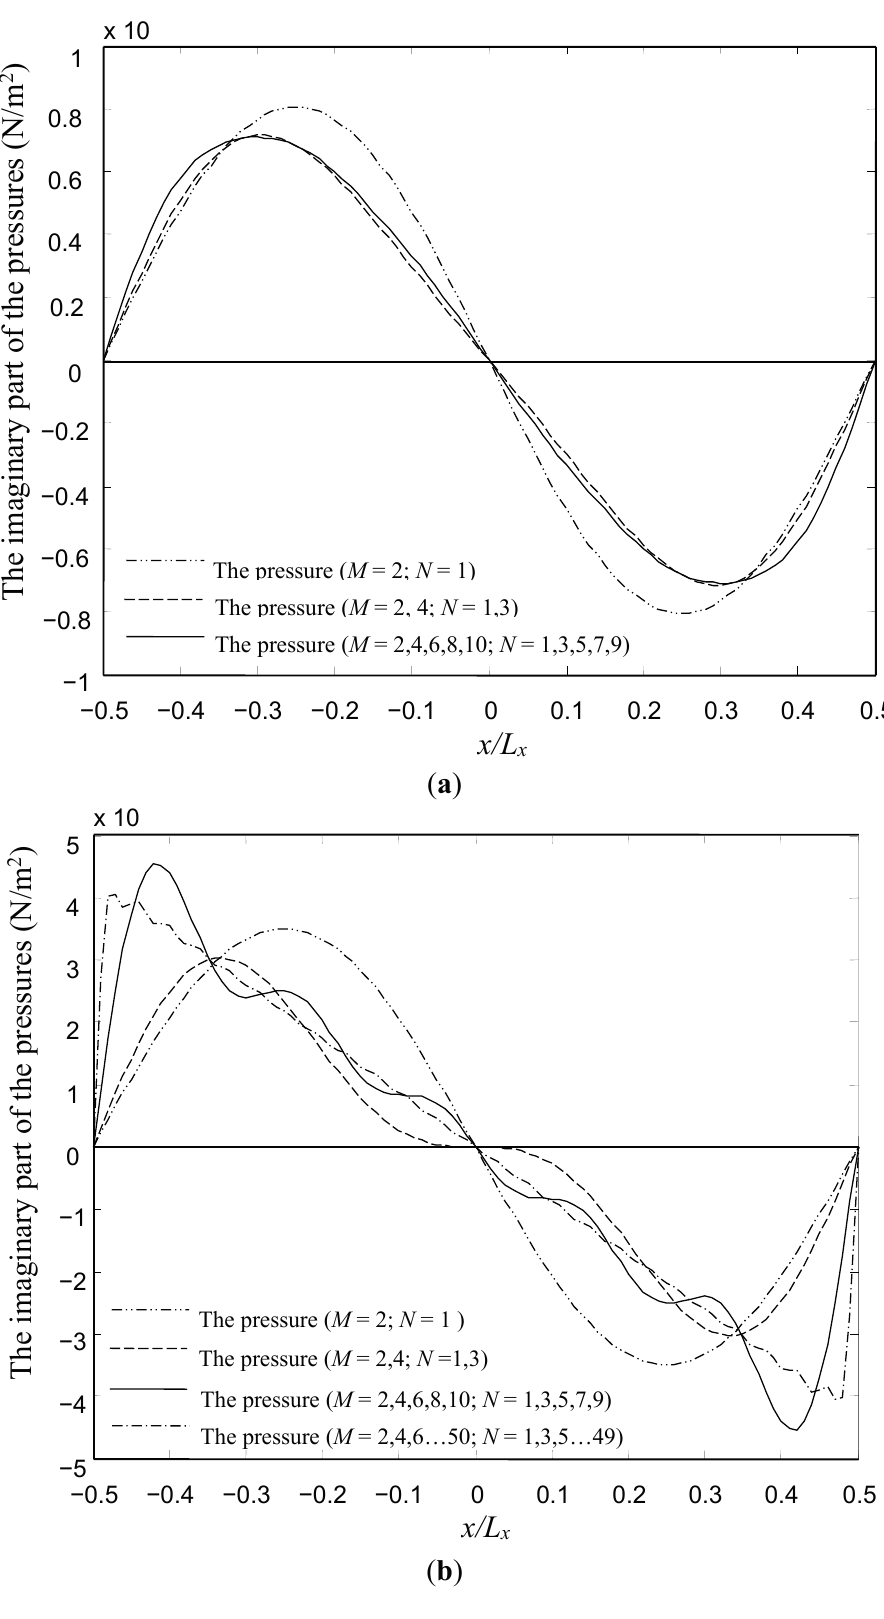
Figure 5. Convergence analysis of the series for the pressures in the air gap. ( a ) Comparison of the imaginary parts of the pressure at y = 0 in the case of l h / l p = 0.1 and ( b ) comparison of the imaginary parts of the pressure at y = 0 in the case of l h / l p =